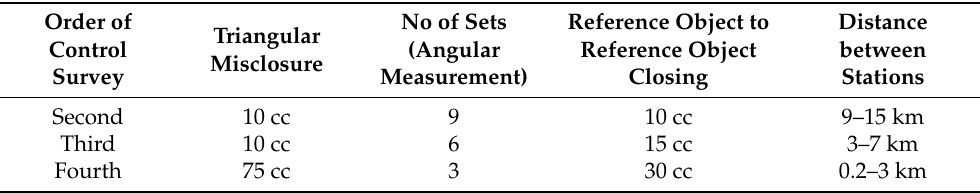
Table 2. The accuracy and precision standards of second-, third-, and fourth-order control stations. Order